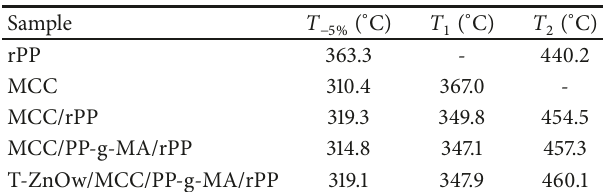
Table 3: Parameters of MCC and pure rPP and rPP based compos- ites gotten from